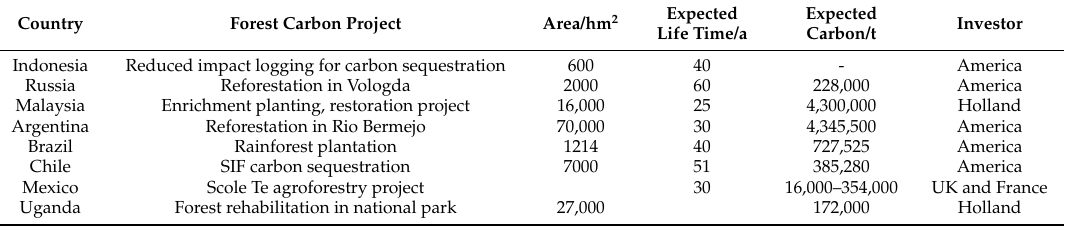
Table 1. The condition of developing forest carbon sequestration projects around the world. Country Forest Carbon Project Area/hm 2 Expected Life Time/a Indonesia Reduced impact logging for carbon